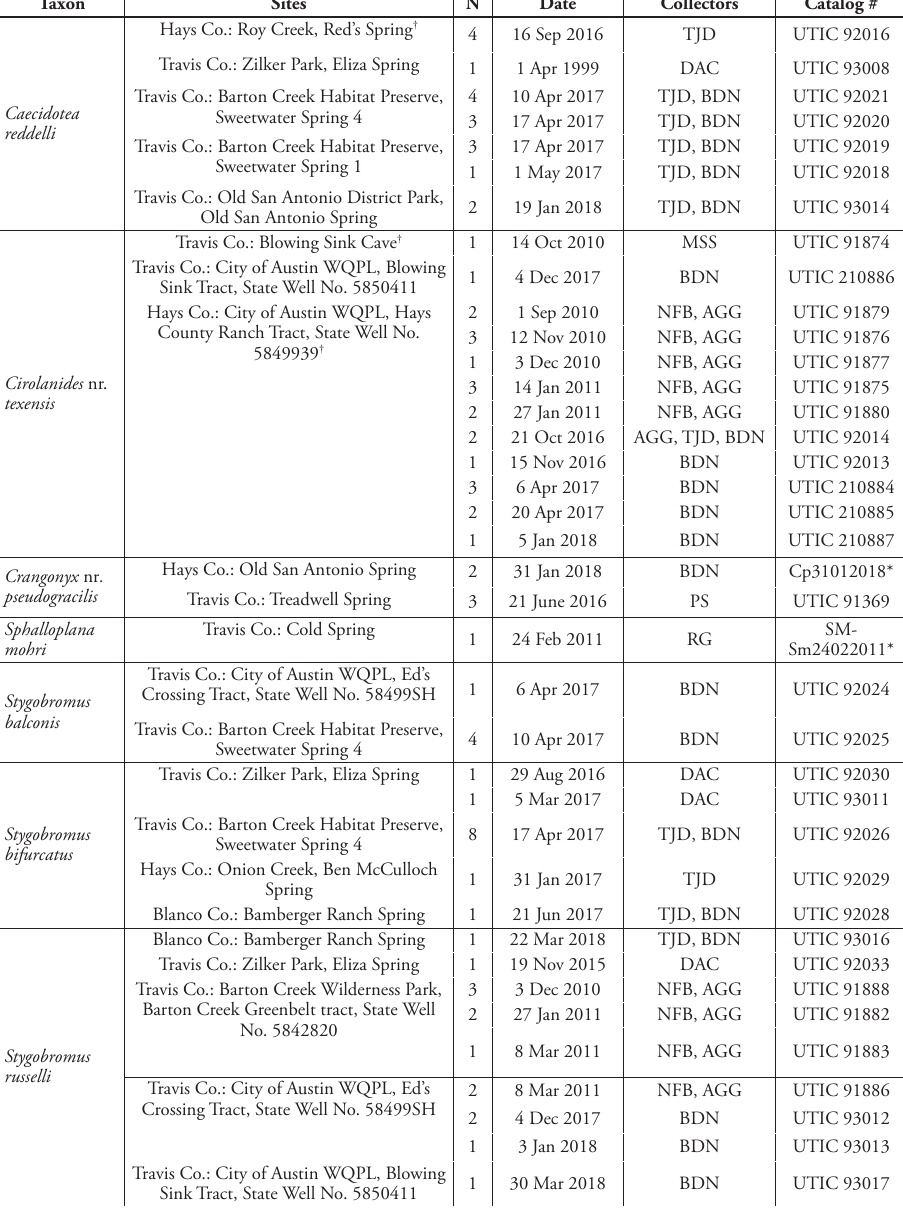
Table 2. Voucher specimens. Complete listing of all specimens collected. UTIC = University of Texas Insect Collection. Collector initials are as follows: TJD = Thomas J. Devitt; BDN = Bradley D. Nissen; MSS = = Dee Ann Chamberlain; PS = Peter Sprouse. N = Specimens collected. † = new county record. * = specimen accessioned at San Marcos US Fish and Wildlife Service Fish